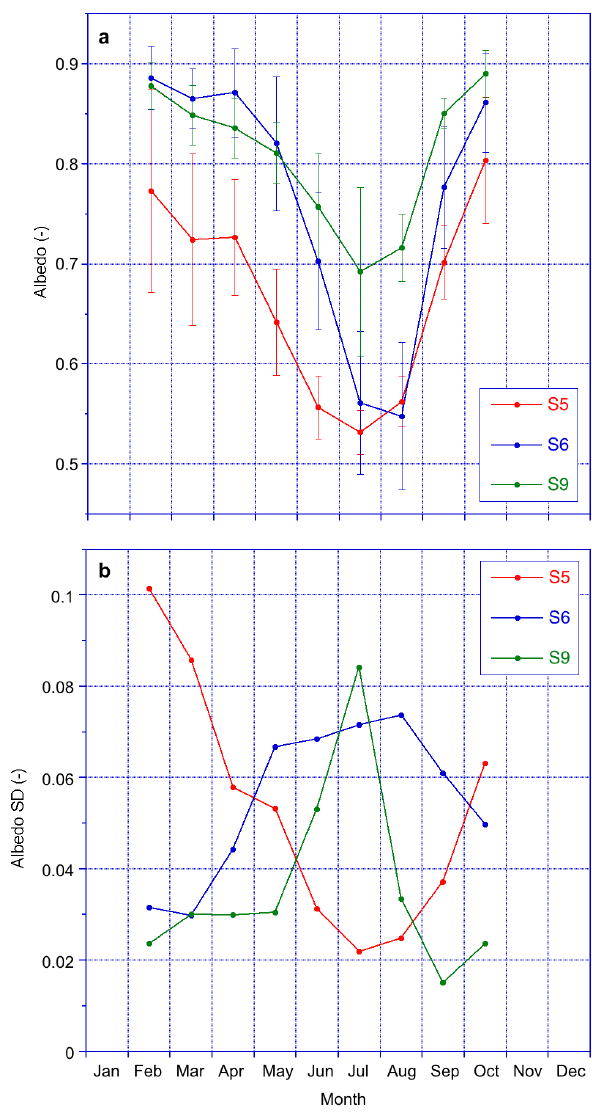
Fig. 6. Average seasonal cycle of albedo (a) (error bars indicate standard deviation for the 7-yr period) and average seasonal cycle of the albedo standard deviation (SD) (b)